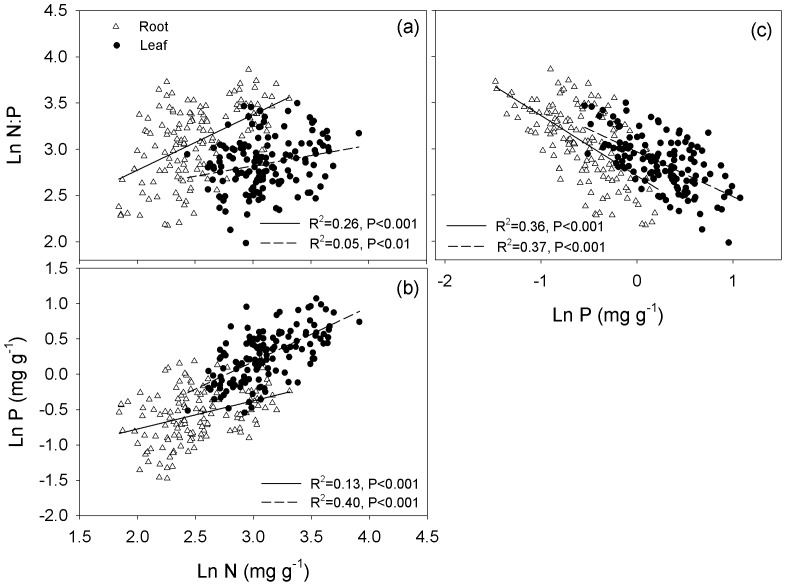
The relationship between the N and P concentrations (b) and the N∶P ratio (a, c) for roots and leaves across all species on the northern Tibetan Plateau.The solid line represents the root fitted straight line, the dashed line represents the leaf fitted straight line.